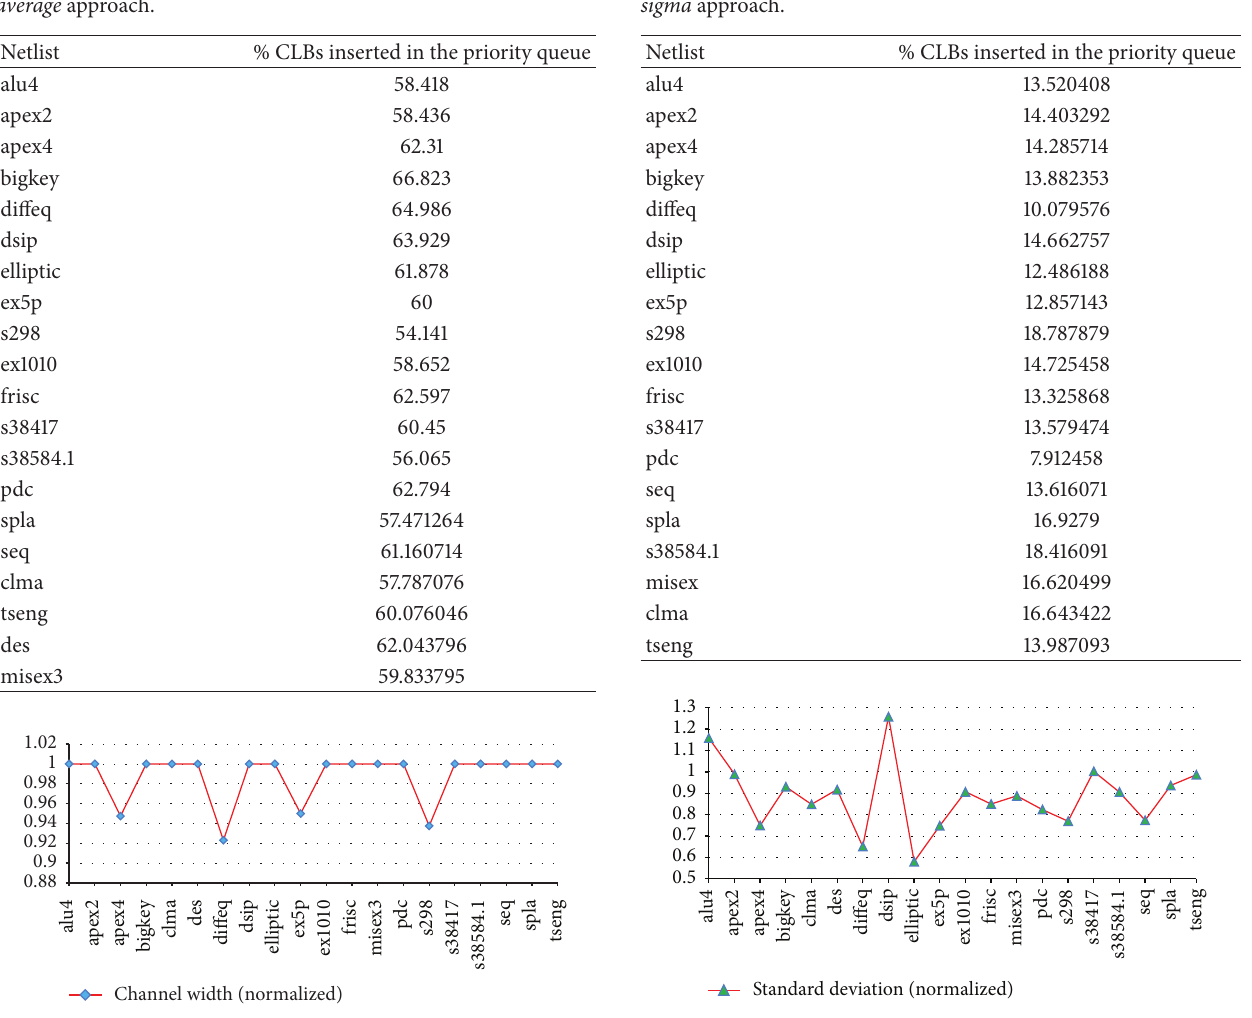
Figure 1: Comparative results of channel width for diffusion based placement algorithm using fixed approach normalized to the respective results from VPRs placement algorithm for cluster size 𝑁 = 4 .